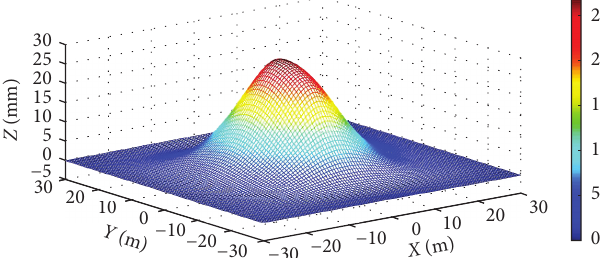
Figure 15: Heaving displacement of ground frost heave caused by freezing for 30 days (mm, α � 10 ° ).